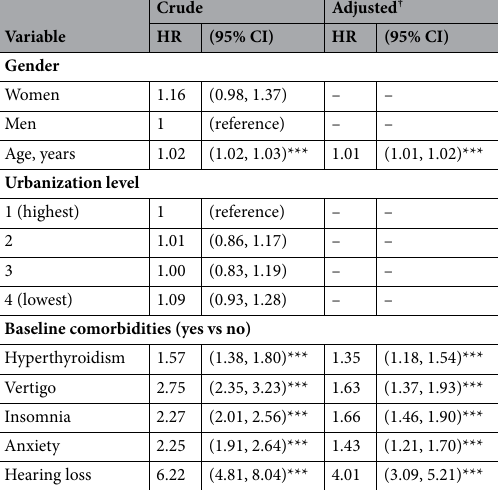
Table 3. Cox model with hazard ratios and 95% confidence intervals of Tinnitus associated with Hypothyroidism and covariates. Crude HR*, relative hazard ratio; adjusted HR † : multivariable analysis including age, and comorbidities of vertigo, insomnia, anxiety, and hearing loss; *p < 0.05, **p < 0.01, ***p < 0.001.